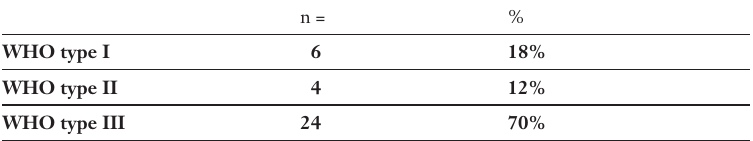
Distribution ofT- and N-stage according to TNM classification.